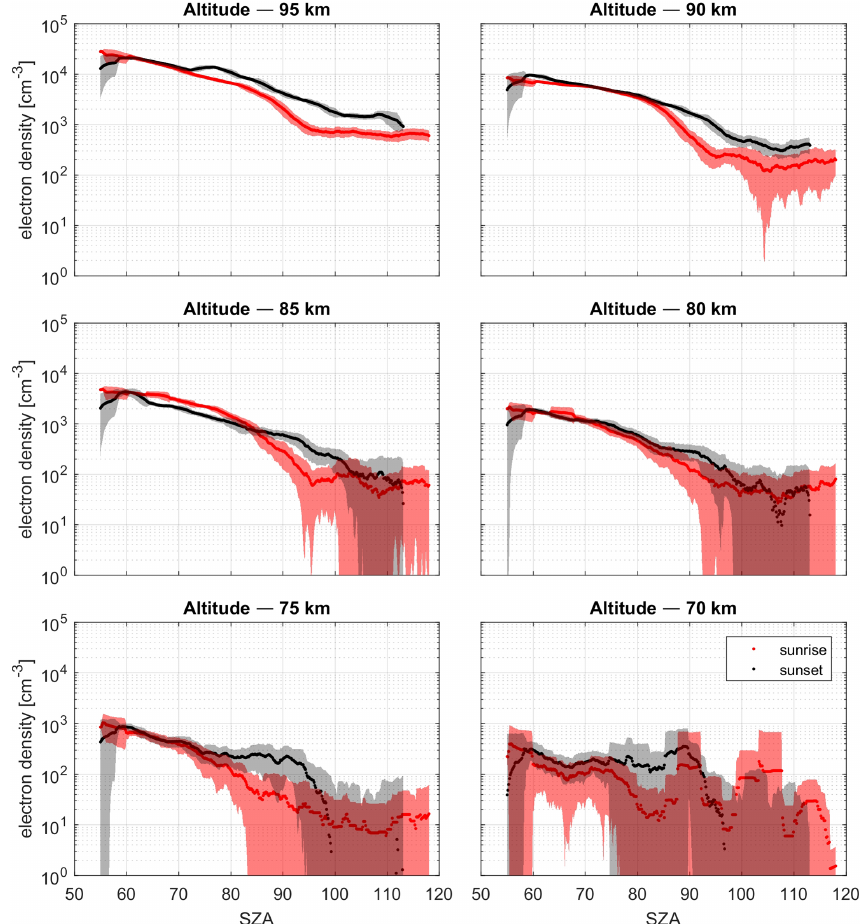
Figure 2. Sunset and sunrise comparison of the measured electron density at altitudes of 95 down to 70km as a function of solar zenith angle (SZA). Solid lines represent the 20-point running mean of two sunrise measurements and four sunset measurements. Shaded areas represent the 20-point running standard deviation. Sunset values represent a 25% trimmed mean to remove outliers due to sporadic E layers.